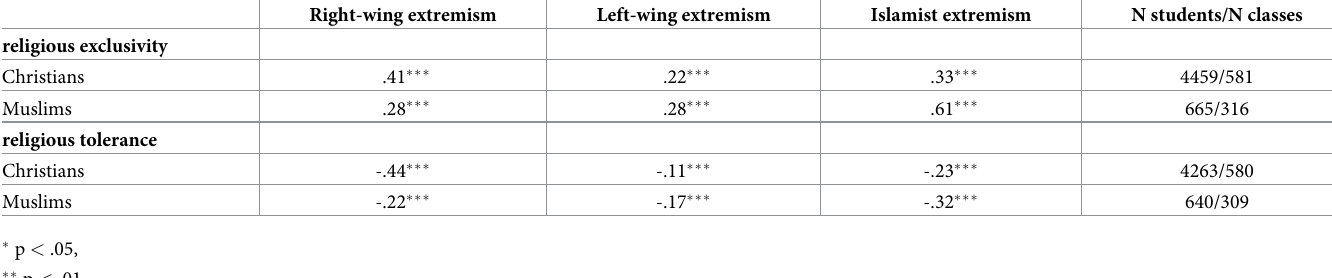
Table 5. Correlations between religious exclusivity/religious tolerance and extremism attitude scales (standardised correlations shown; estimator